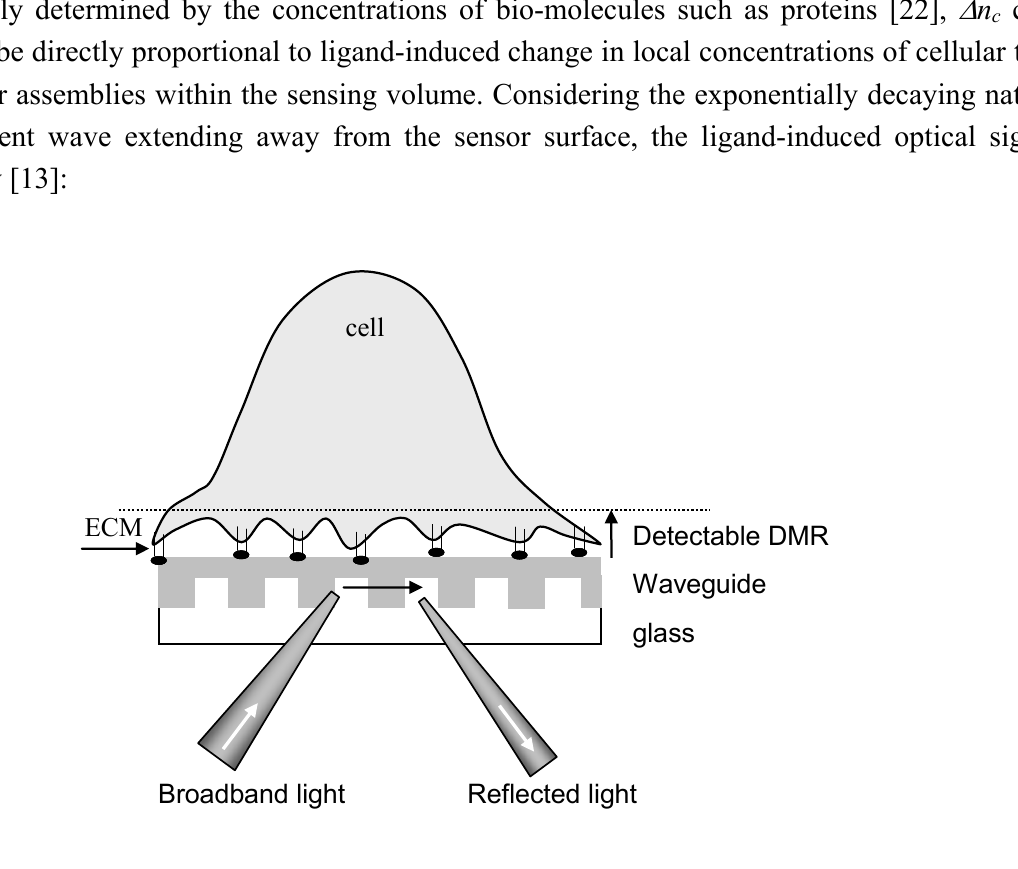
Figure 2. A three-layer waveguide system for detecting ligand-induced dynamic mass redistribution signals in living cells using RWG biosensor. Cells are anchored to the sensor surface through interaction with the extracellular matrix